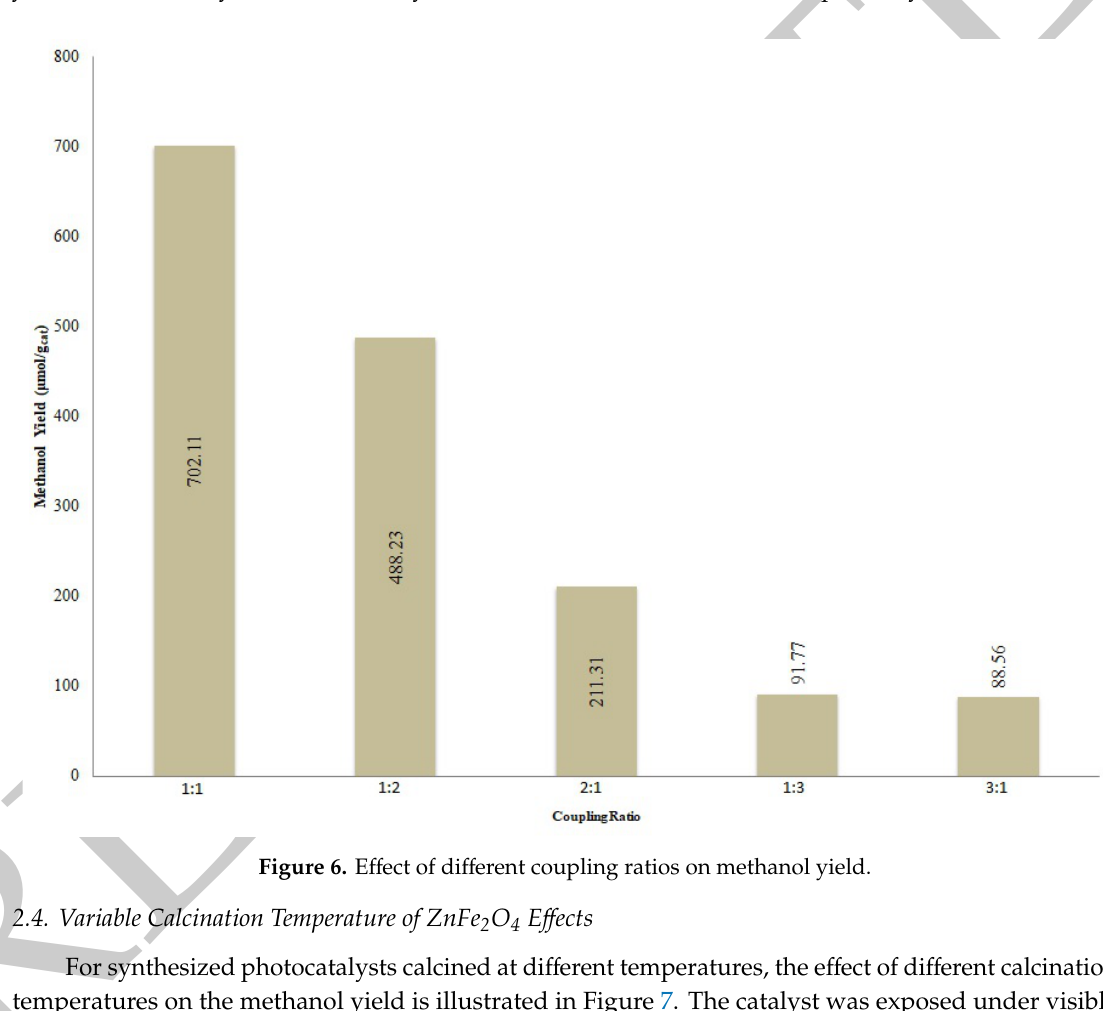
Figure 6. E ff ect of di ff erent coupling ratios on methanol Figure 6. Effect of different coupling ratios on methanol yield.